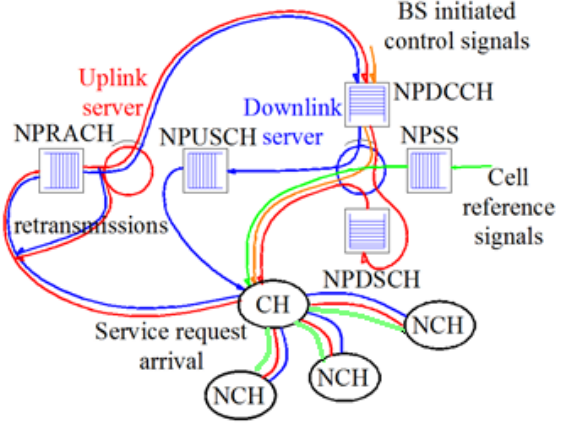
Figure 14. LEACH-based NB-IoT traffic queuing